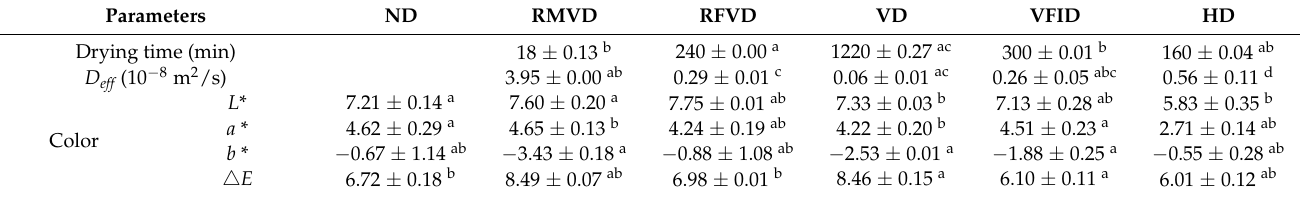
Figure 1. Drying curve ( a ) and drying rate curve ( b ) of Codonopsis pilosulae with different drying methods. VFID: vacuum far infrared drying; RFVD: radio frequency vacuum drying; HD: hot air drying. Different drying methods were carried out at a temperature of 55 °C. Table 2. Effects of different drying methods on drying characteristics and color parameters of Codonopsis .